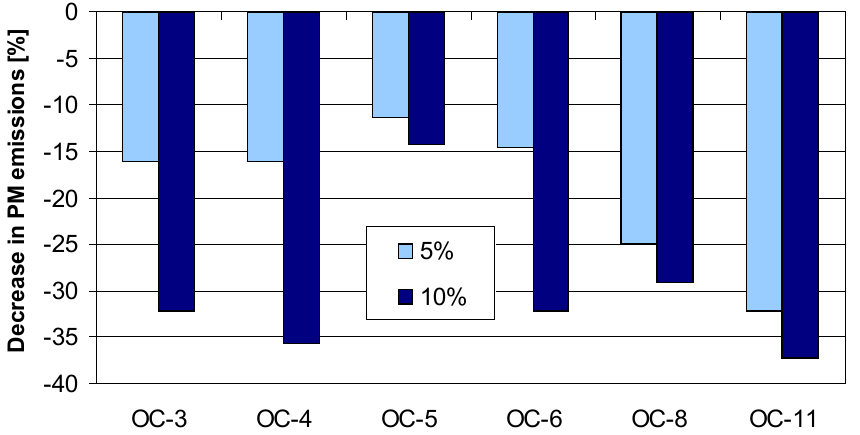
Figure 6. Reduction of PM emissions as a function of type and content of oxygenated compound in relation to fueling with conventional diesel fuel.